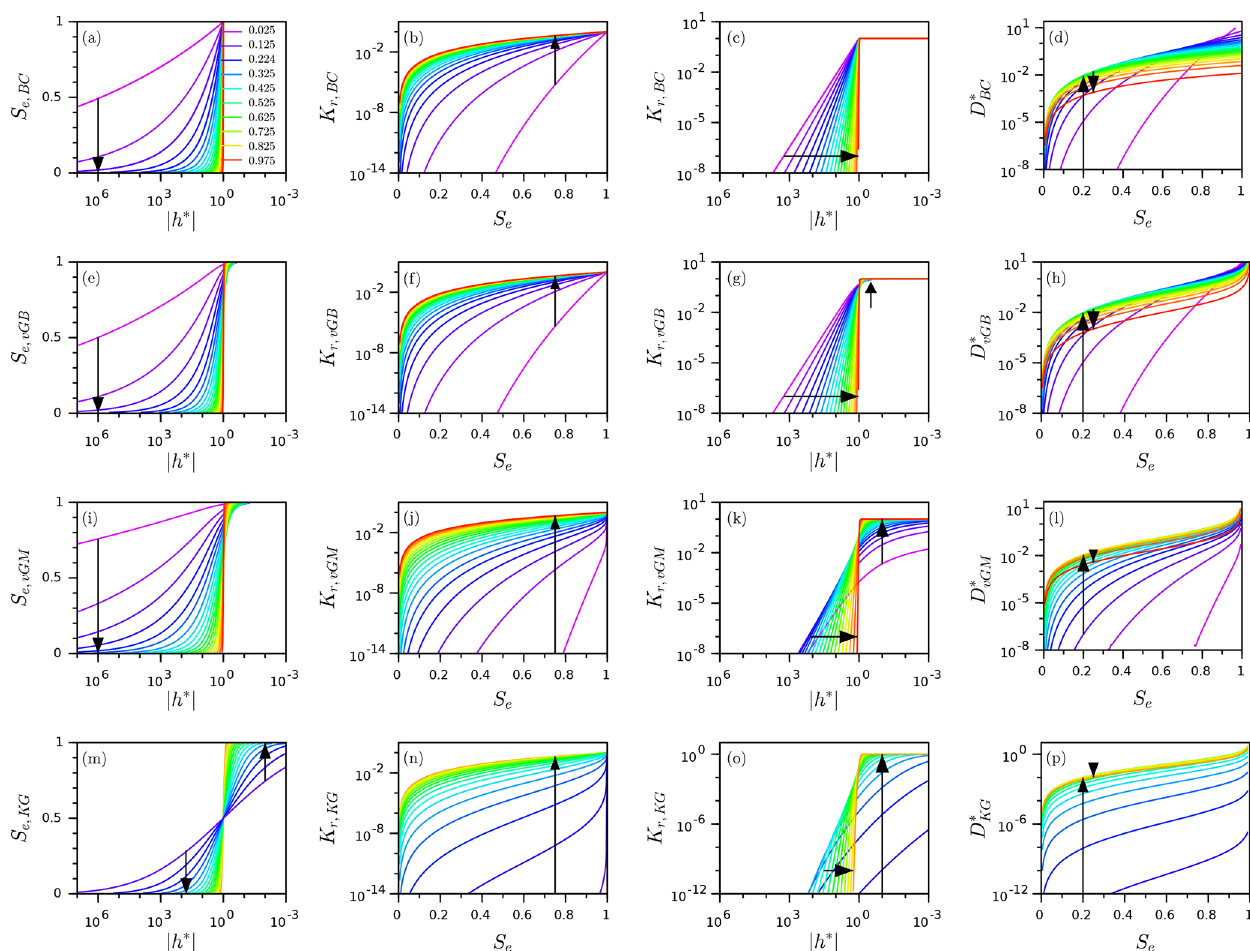
Figure 2. Impact of the shape index, x , on the WR and HC functions versus the selected hydraulic models: WR functions, S e (h ∗ ) (a, e, i, m) ; HC functions, K r (S e ) (b, f, j, n) or K r (h ∗ ) (c, g, k, o) ; and diffusivity function D ∗ (S e ) functions (d, h, l, p) for the Brooks and Corey (BC) (a– d) ; van Genuchten–Burdine (vGB) (e–h) ; van Genuchten–Mualem (vGM) (i–l) ; and Kosugi (KG) models (m–p) . The arrows indicate in- creasing values of the shape index x . The hydraulic parameters λ BC , m vGM , m vGB , and σ KG were computed as a function of x using Eq. (55), with l vGM = l KG = 1 2